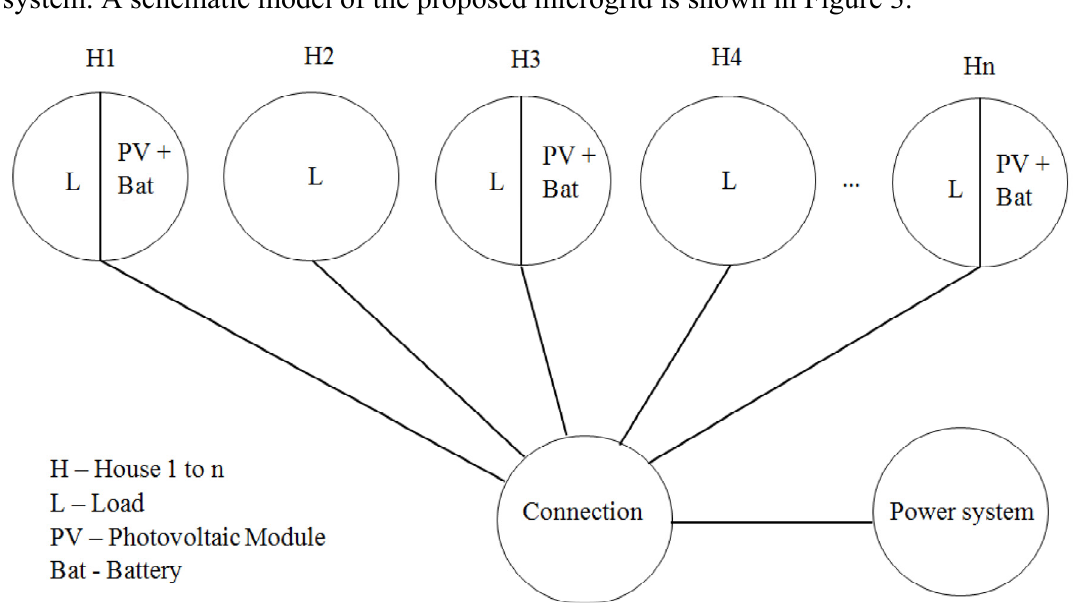
Figure 3. Schematic drawing of the proposed